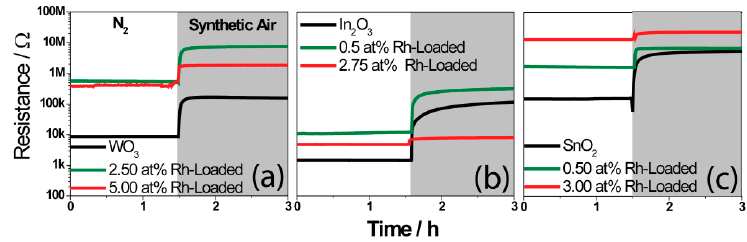
Figure 6. The resistances of the sensors, based on WO 3 ( a ), In 2 O 3 ( b ), and SnO 2 ( c ), are shown in N 2 and dry synthetic air background (80% N 2 and 20% O 2 ).